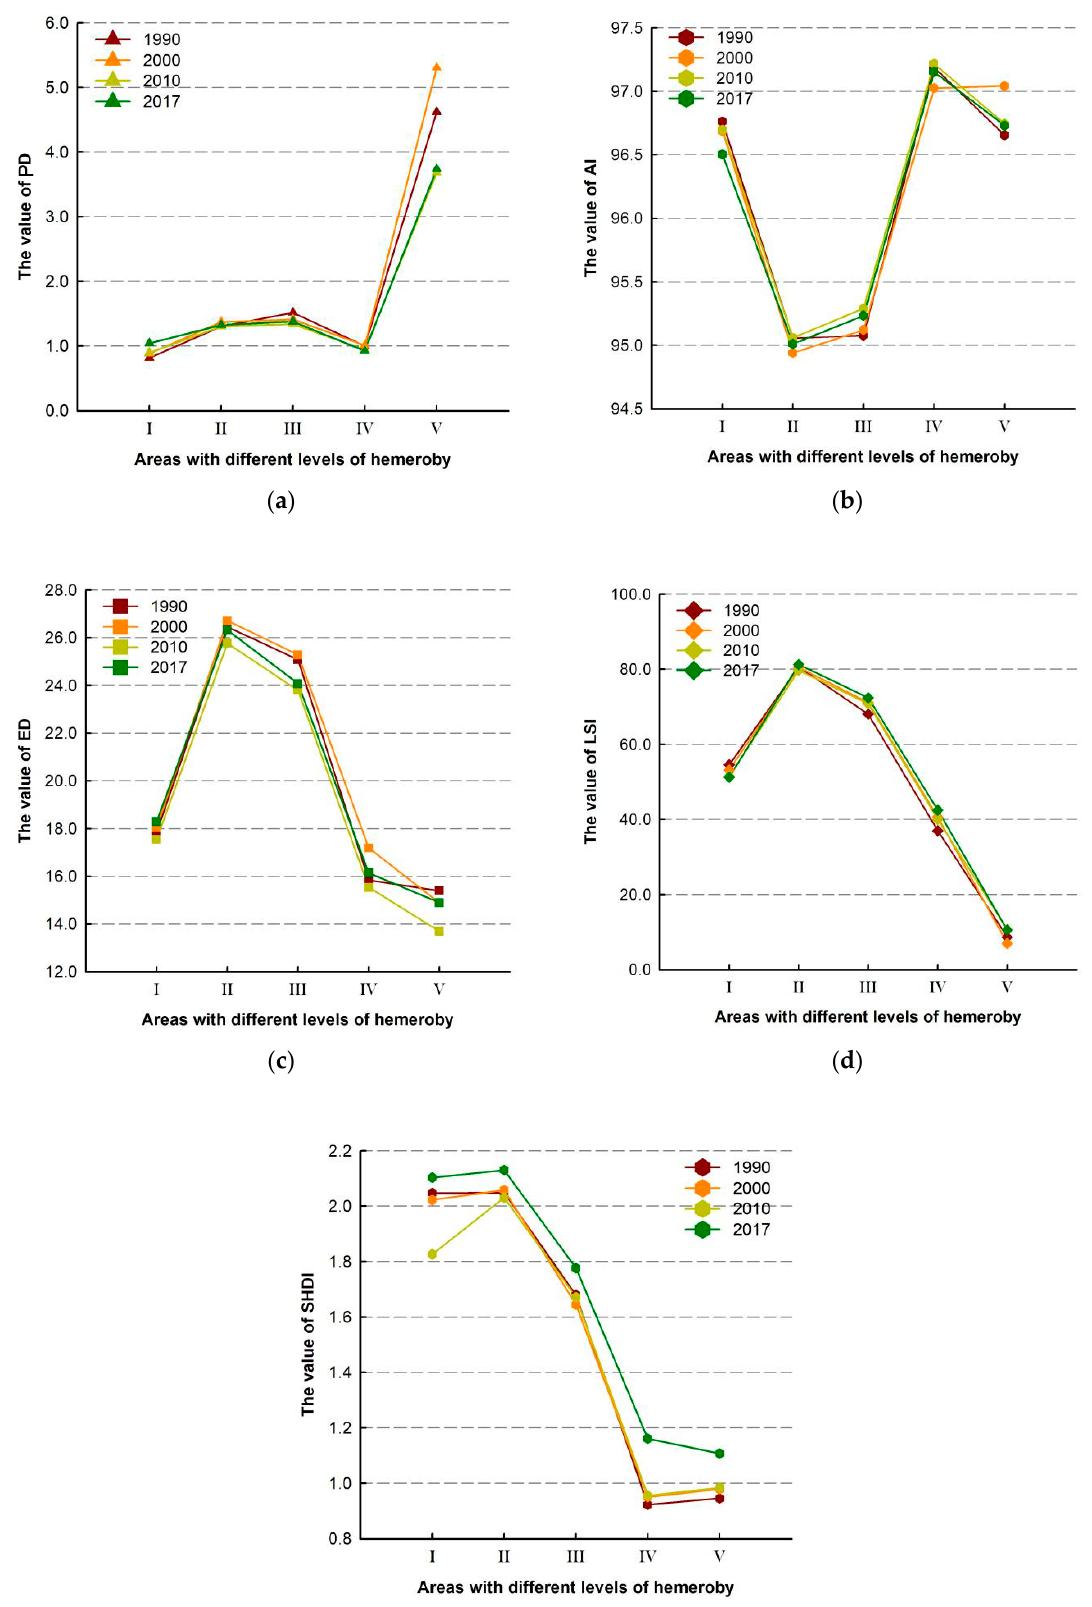
Figure 7. Landscape pattern indexes in the areas with di ff erent levels of hemeroby: ( a ) Change of PD; ( b ) Change of AI; ( c ) Change of ED; ( d ) Change of LSI; ( e ) Change of